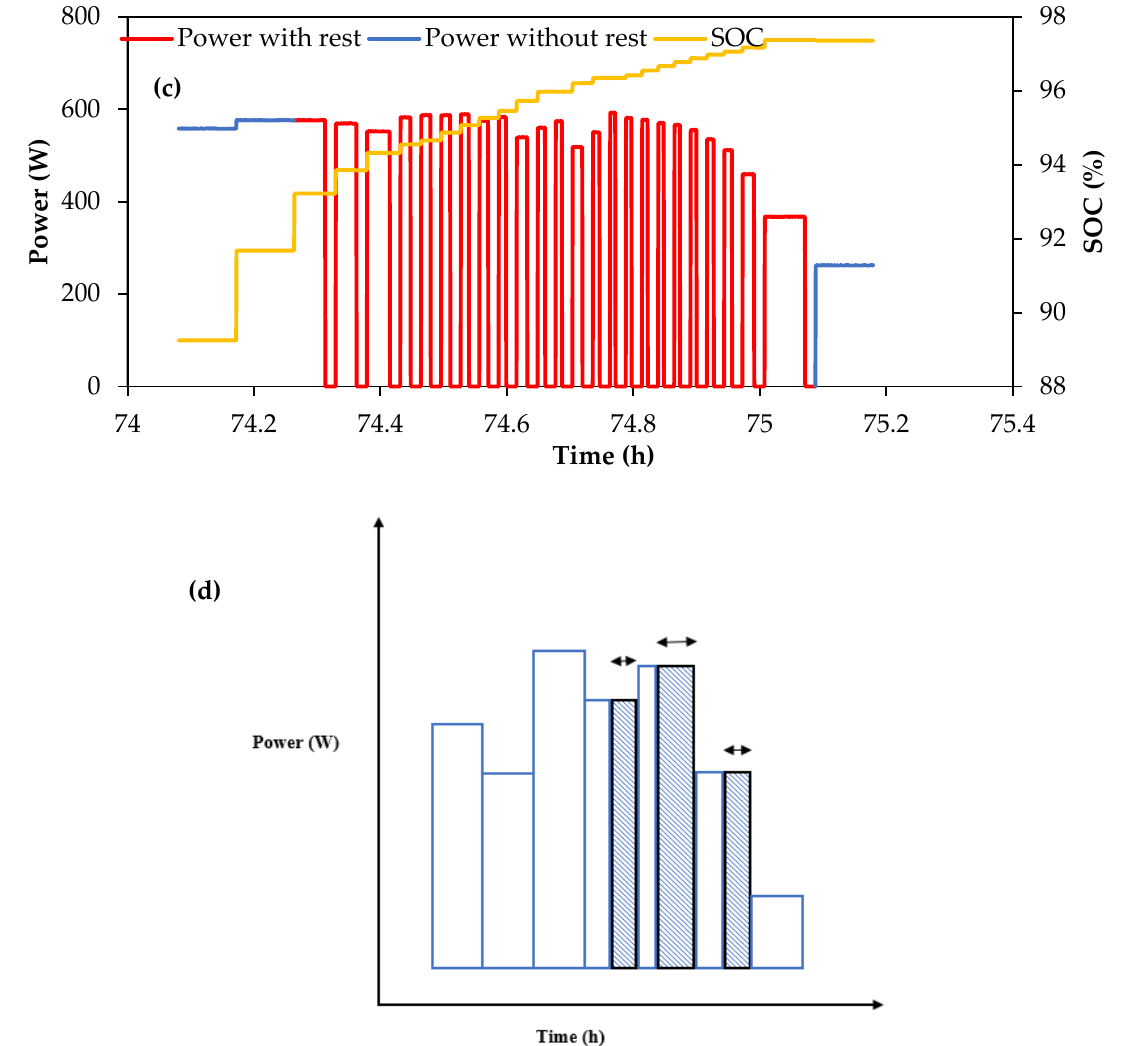
Figure 3. VRFB performance for S P = 1 / 2 and S T = 1 / 2 showing with 30 L electrolyte: ( a ) Complete 7-day profile with SoC variation. ( b ) Discharge failure in 1st discharge cycle. ( c ) Charge failure in 7th day charge. ( d ) Schematic diagram of battery with failure to deliver power and without failure.